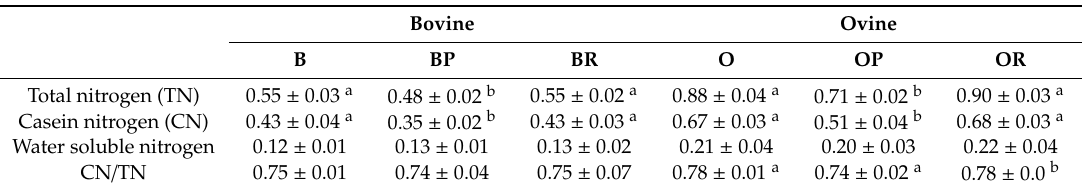
Table 2. E ff ect of microfiltration on the nitrogen components (%) of partially defatted bovine (B) or ovine (O) milk, bovine permeate (BP), bovine retentate (BR) (mean ± SD, n = 3), ovine permeate (OP) and ovine retentate (OR) (mean ± SD, n = 5).